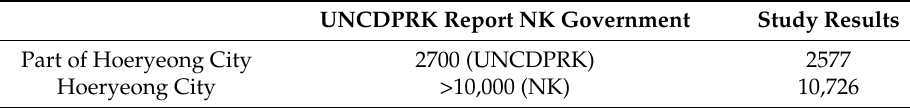
Figure 9. High-resolution Google Earth images of the study area.